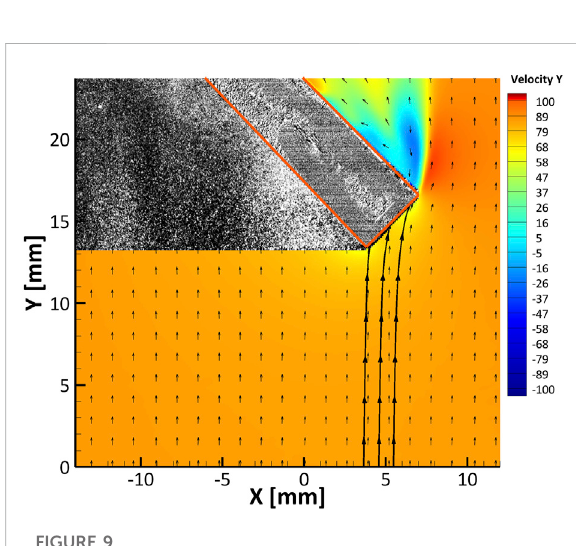
FIGURE 9 Axial velocity contours (m/s) with vector fi eldand streamtube overlaid on image of probe to show approximate location for the M = 0.25, θ = 45 ° test case. Sampling probe boundaries are highlighted in